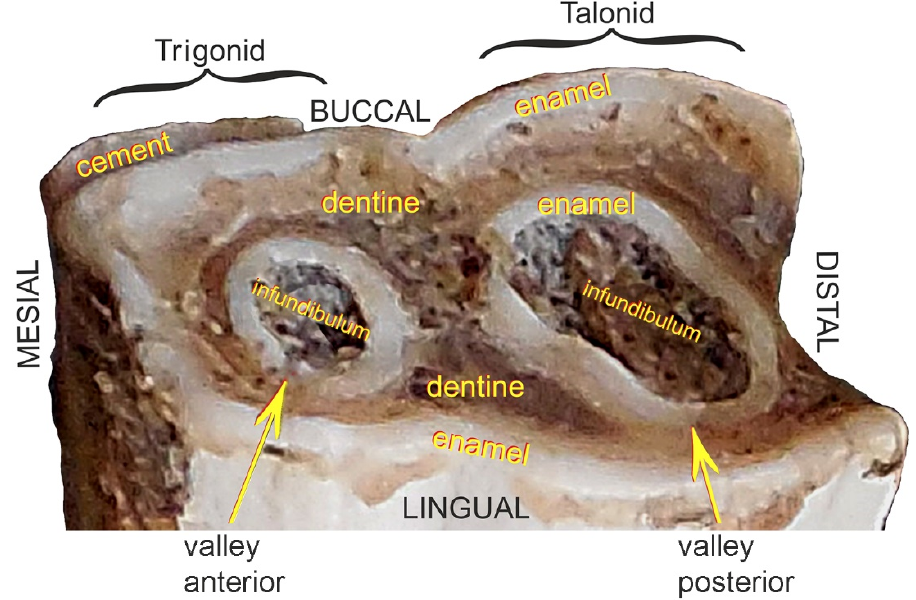
Figure 4. Description of anatomical structures of the third premolar (P 3 ) of the white rhinoceros female.